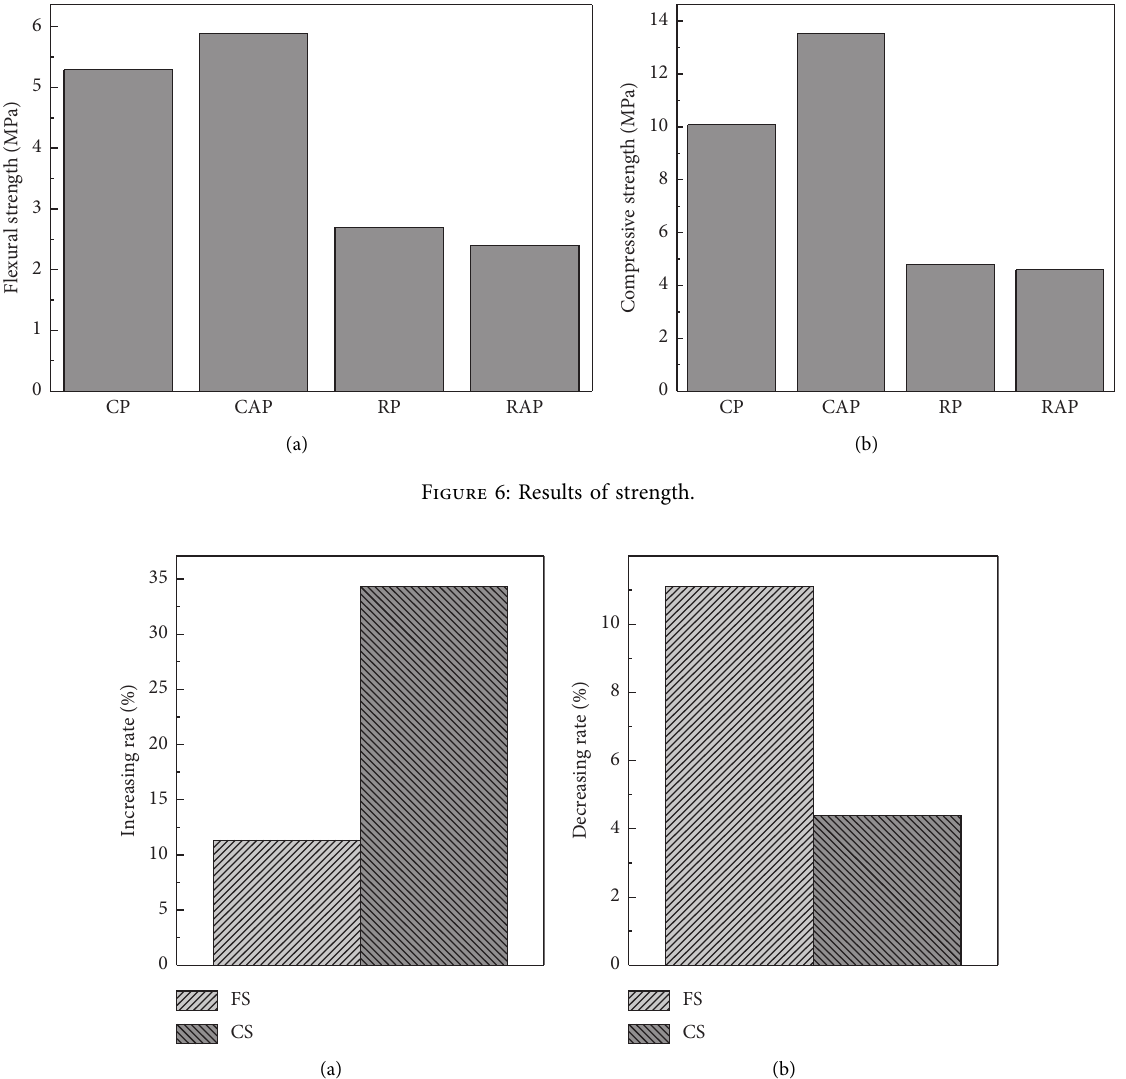
Figure 7: The strength changing rate of commercial plaster and recycled plaster aluminate cement mixes. (a) The increasing rate of CAP. (b) The decreasing rate of RAP.